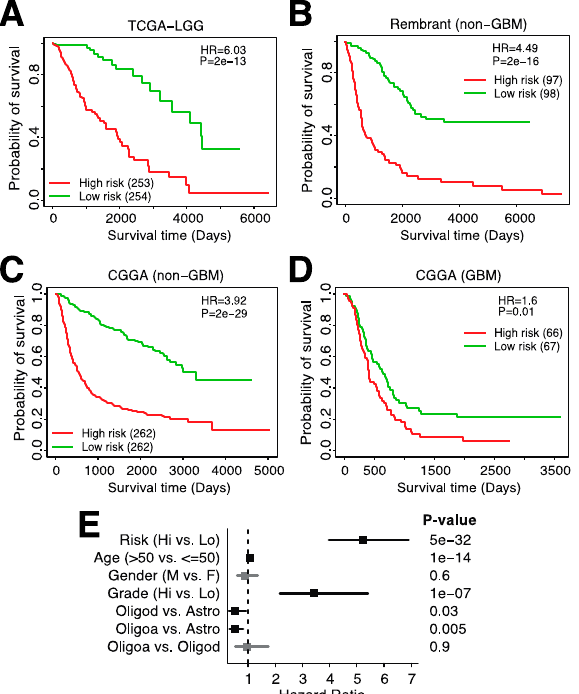
Figure 7. A 23-gene risk score is highly associated with overall survival in low-grade glioma. Kaplan–Meier plot showing the association between overall survival and the 23-gene risk score in ( A ). TCGA-LGG, ( B ). the Rembrandt dataset (mRNAseq_693, non-GBM), ( C ). CGGA (mRNAseq_693, non-GBM) and ( D ). CGGA (GBM). ( E ). Forest plot of hazard ratios derived from multivariable Cox regression analysis including the listed variables.